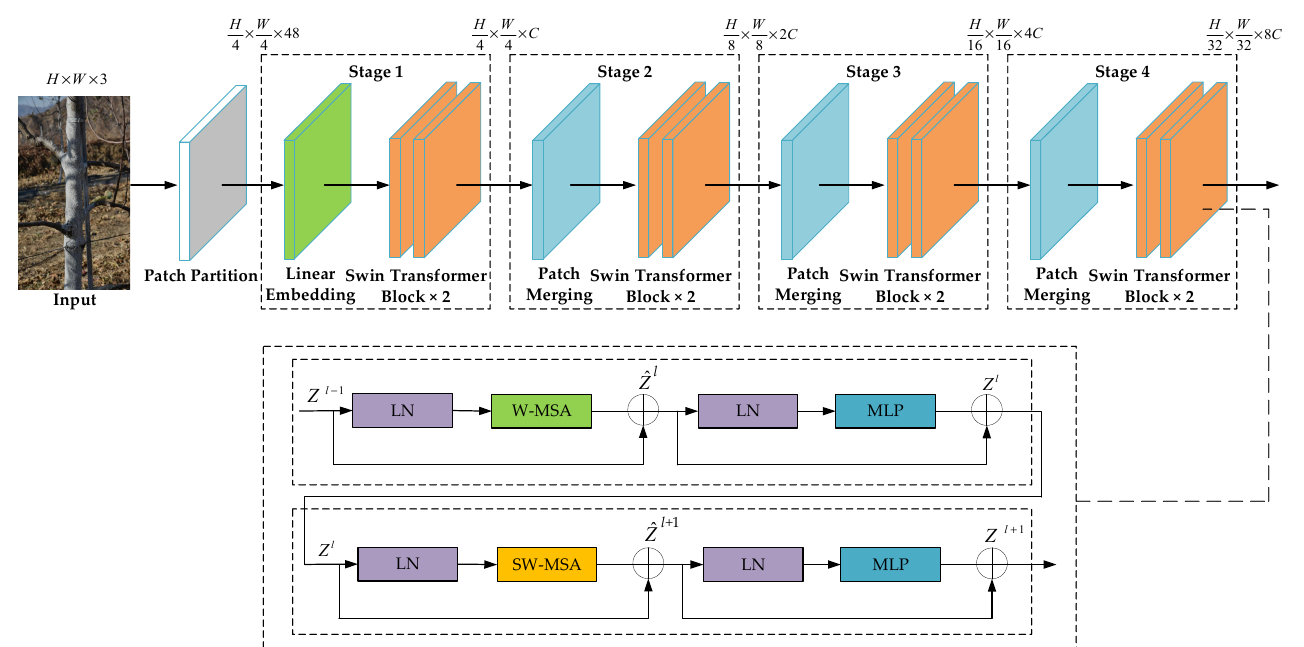
Figure 4. Swin Transformer overall frame diagram.